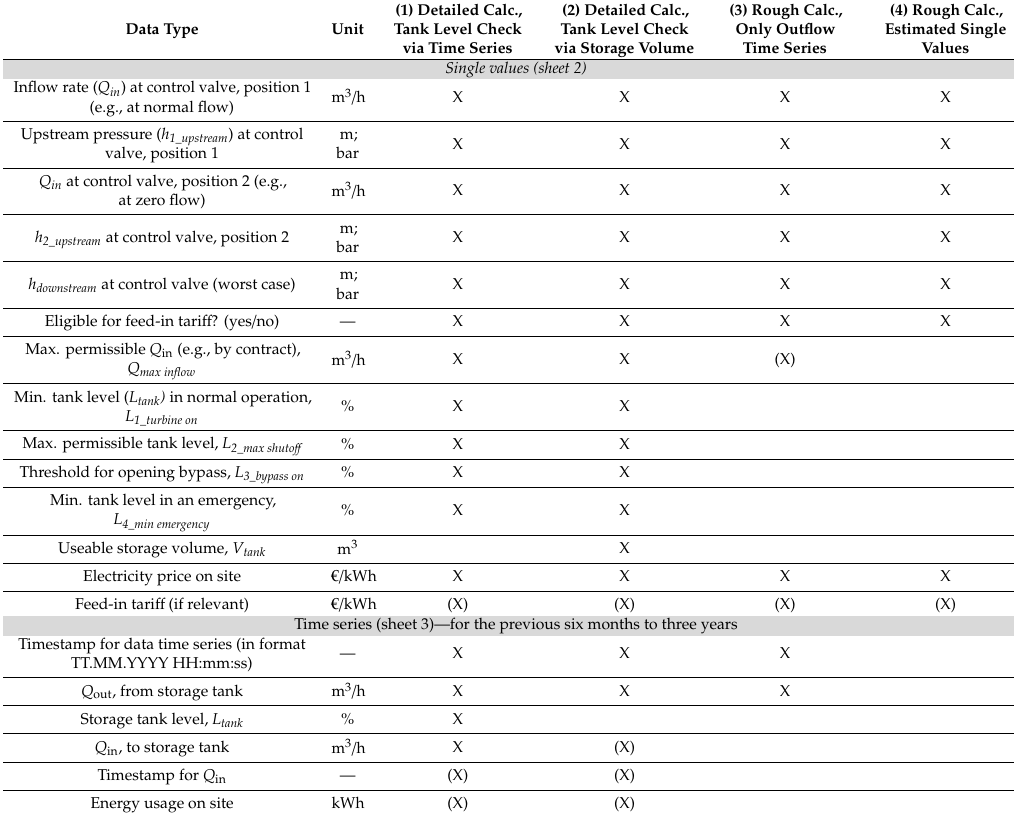
Table A1. Data requirements depending on desired quality of results (and corresponding calculation option): “X” = required and “(X)” =